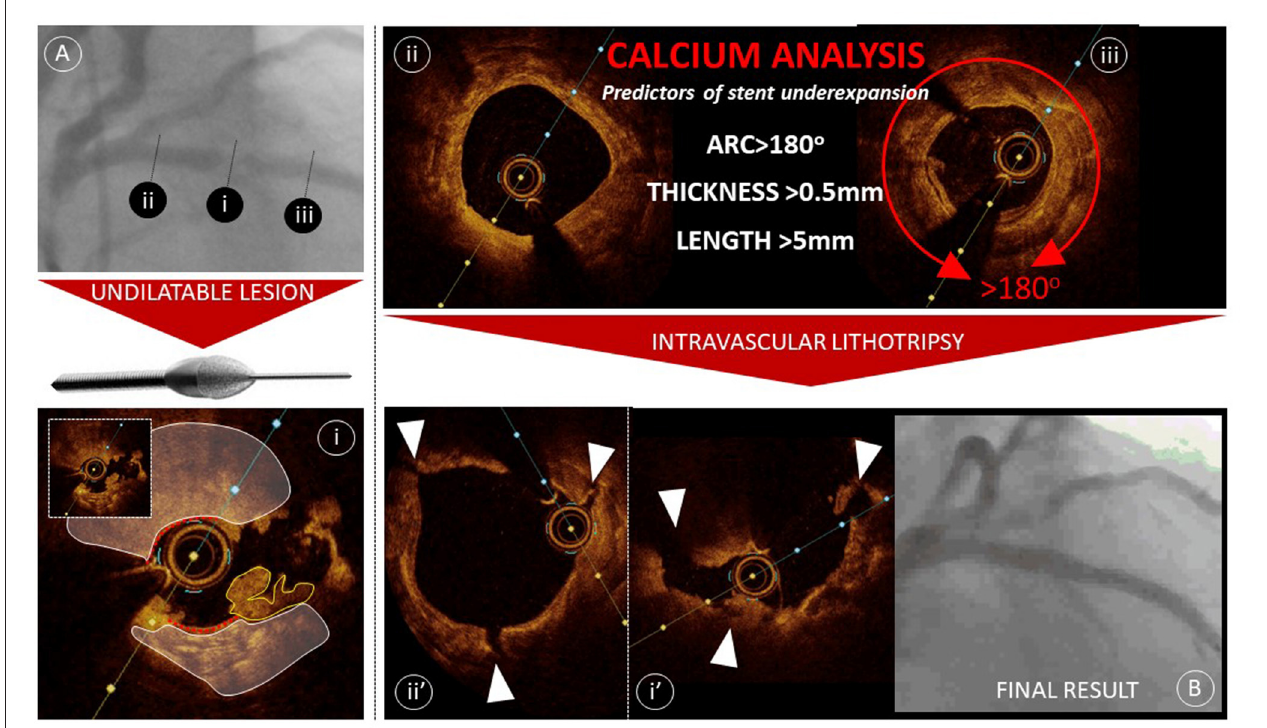
FIGURE 2 | Calcium modification guided by OCT. Panel A—demonstrates a severe mid-left anterior descending artery lesion crossable by an interventional wire but undilatable. OCT imaging is achieved following passage of a 1.5mm rota-link burr (Boston Scientific) and OCT image i demonstrates heavy burden calcification (white outlined and shaded regions) with evidence of rotablation debulking (red dotted lines) and in-situ thrombus (yellow outline). OCT assessment proximal (image ii) and distal (image iii) to the stenosis demonstrate extensive calcification with relative preservation of the lumen area. Intravascular lithotripsy is deployed to ensure adequate calcium modification and repeat OCT confirms effective calcium fracture (white arrows in images ii’ & i’. Panel B—An acceptable result is achieved following stent